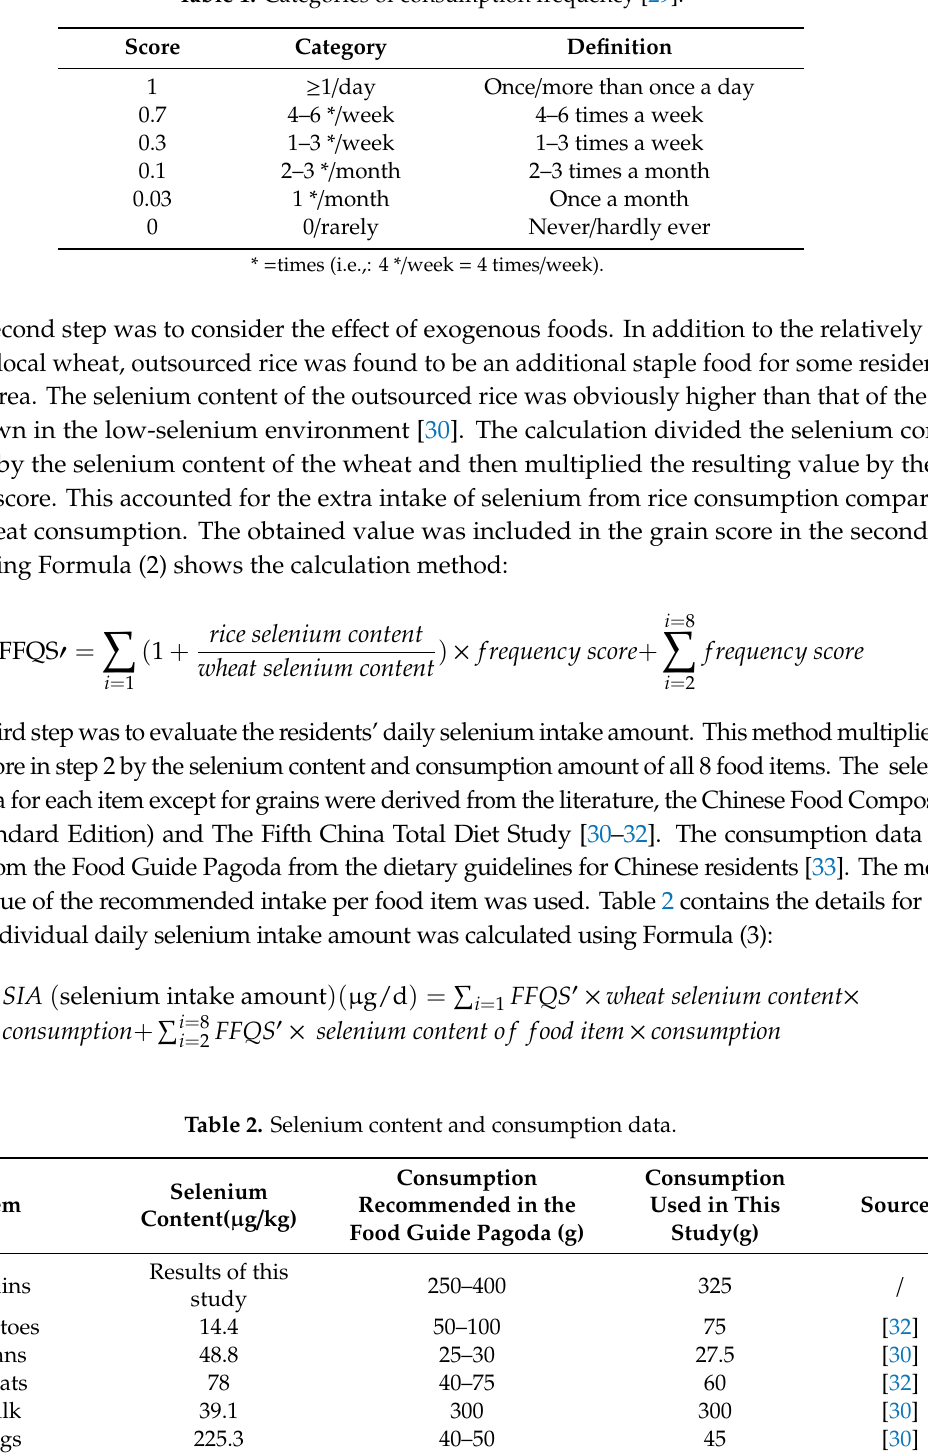
Table 1. Categories of consumption frequency [29].